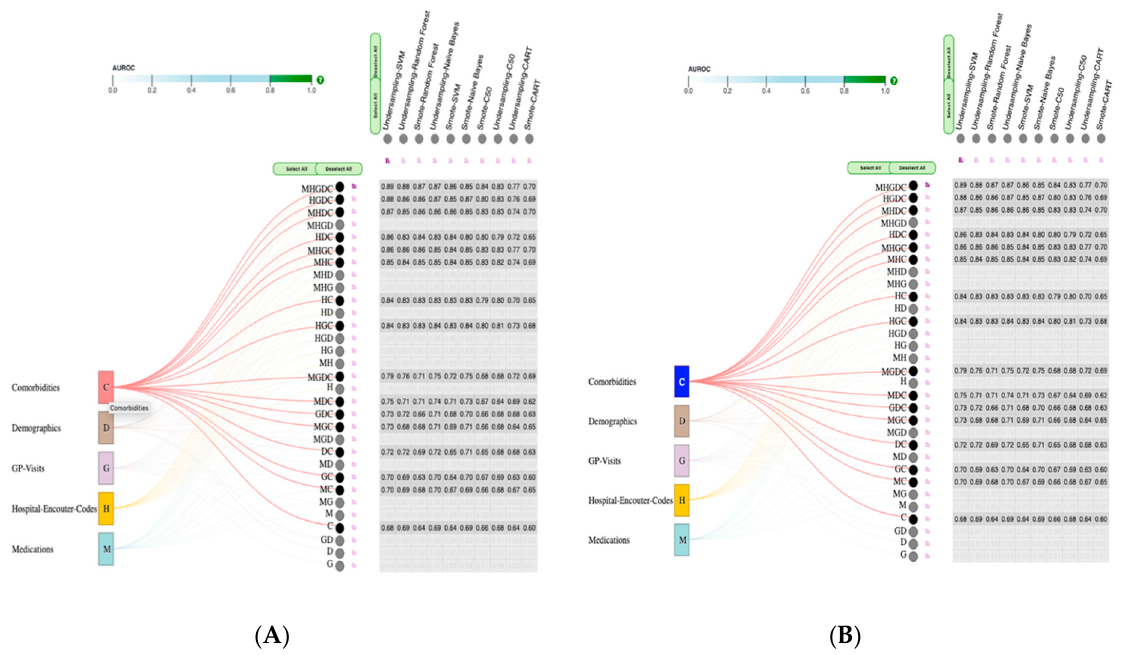
Figure 4. How the system gets updated when users hover over ( A ) or select ( B ) a rectangle representing groups. This interaction highlights all the cells corresponding to the selected subsets, group nodes that contain the selected subset, and links connecting the selected subset node and highlighted group nodes (Figure 5). Users can observe the performance of different analysis techniques by clicking on circles representing the combinations. This interaction highlights all the cells in the heatmap representing the selected column. When a circle gets selected, its color changes to dark blue. As shown in Figure 6, when several subset nodes (or group nodes) and circles representing analysis techniques are selected simultaneously, the color of all the cells that both their rows and columns are selected changes based on the gradient scales mentioned above (i.e., shades of green or blue based on the value of the cell’s